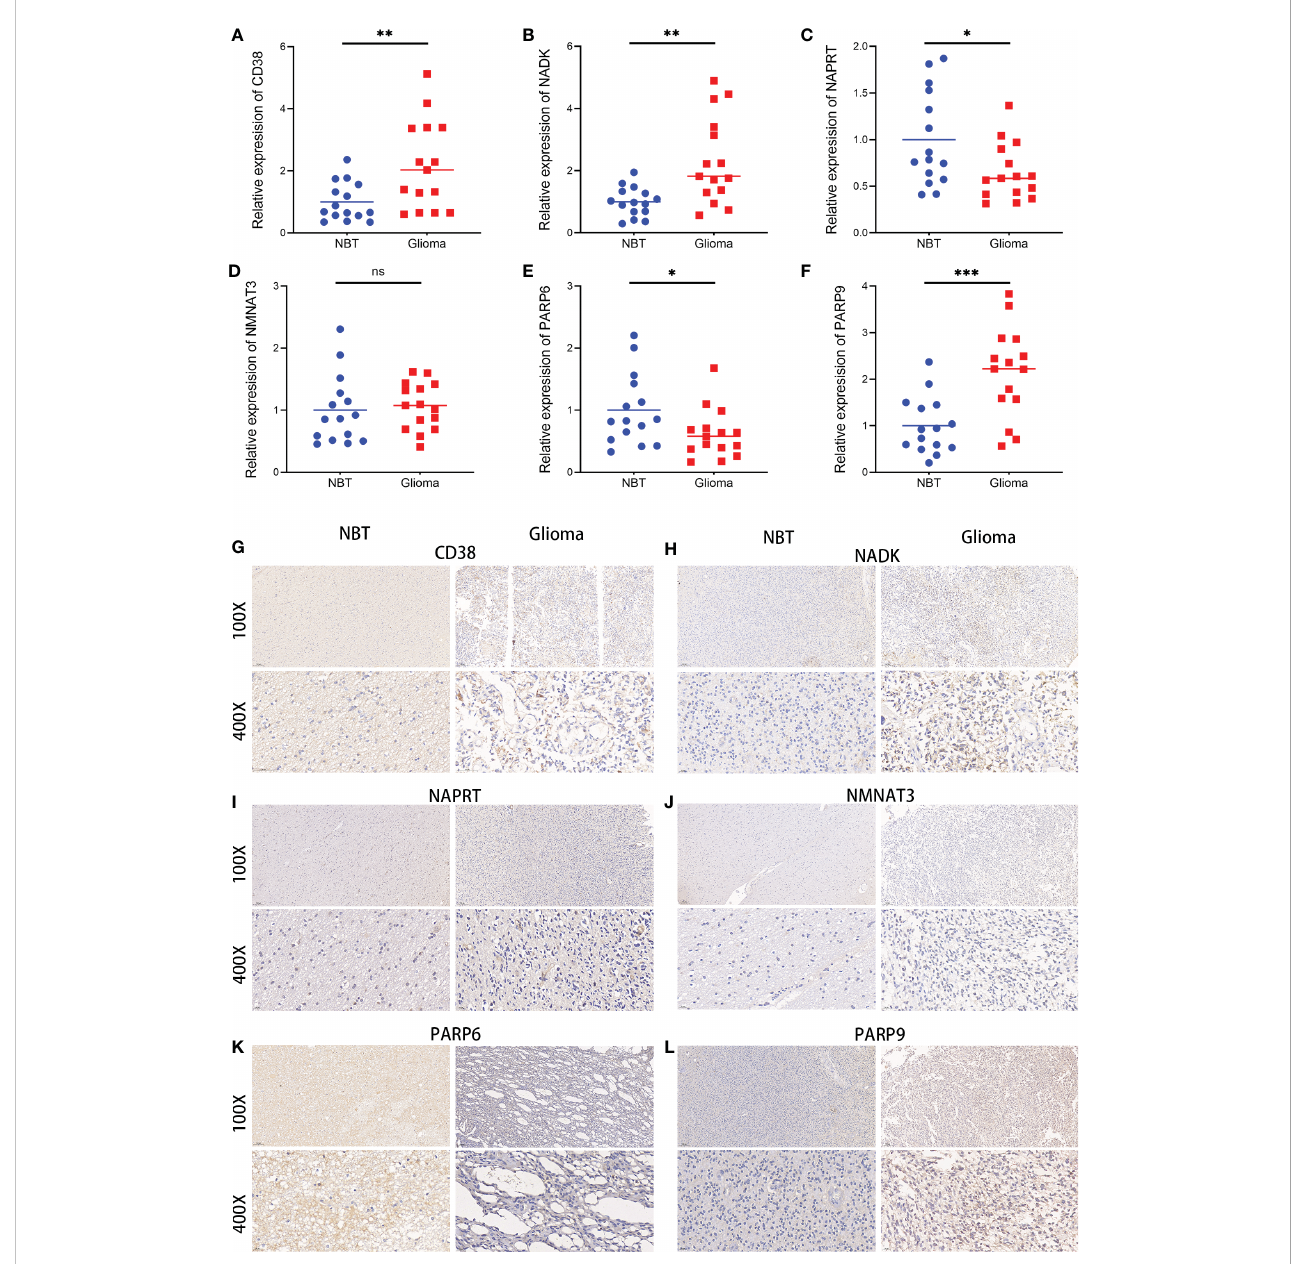
FIGURE 10 Expressions of the six hub NMRGs in glioma and normal tissues. (A – F) The mRNA expressions of the six hub NMRGs in tissues. (G – L) Representative IHC staining of the six hub NMRGs in tissues. ns, not signi fi cant; * p < 0.05, ** p < 0.01, *** p <